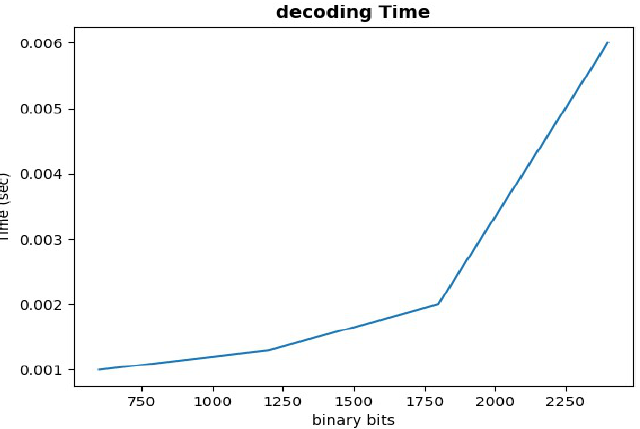
Figure 9. Computational complexity for decoding